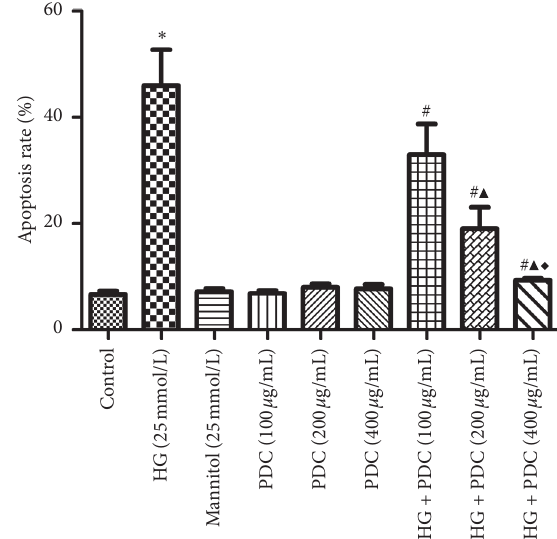
Figure 2: Effects of high glucose and PDC on apoptosis of HSF cells. HSF cells were incubated at high glucose concentration (25mmol/L) or PDC (100, 200, and 400 μ g/mL) for 48h. Apoptosis was detected by flow cytometry. All the data were expressed as x ± S ( n � 3). ∗ P < 0 . 05, compared with the control group; # P < 0 . 05, compared with the high-glucose group; ▲ P < 0 . 05, compared with the high-glucose+ Dendrobium polysaccharide (100 μ g/mL) group; ◆ P < 0 . 05, compared with the high- glucose+ Dendrobium polysaccharide (200 μ g/mL) group.